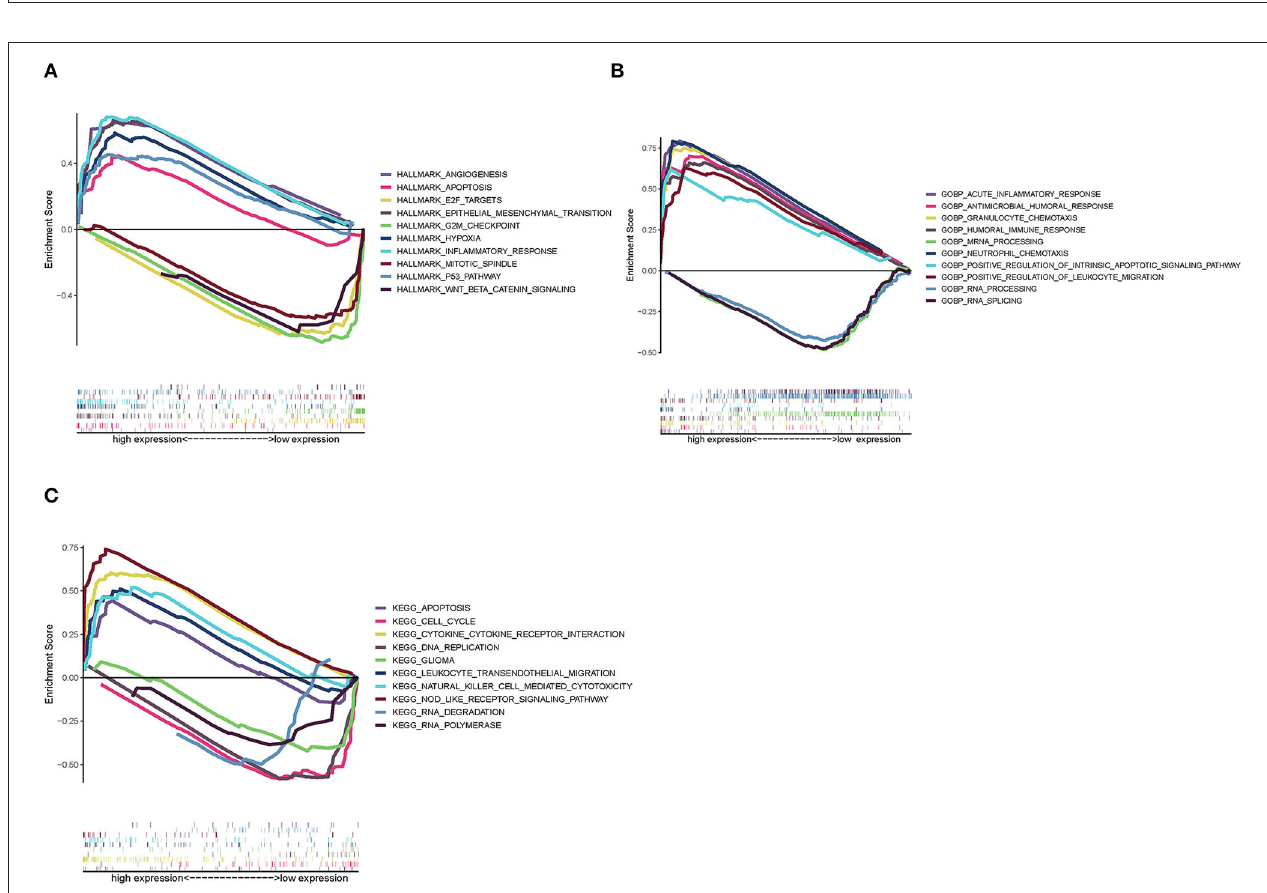
FIGURE 8 | Results of Western blot analysis. (A) Western blot was used to detect the expression levels of SAA1 in glioma cell lines (U87MG and U251) and normal noncancerous glial cell lines (NHA). (B) Quantification of protein expression corresponding to the Western blot. Data are presented as the mean ± SEM. The A.U. of NHA, U87MG, and U251 were 0.557, 0.978, and 0.997, respectively. ** Represented p < 0.01 and * represented p < 0.05.